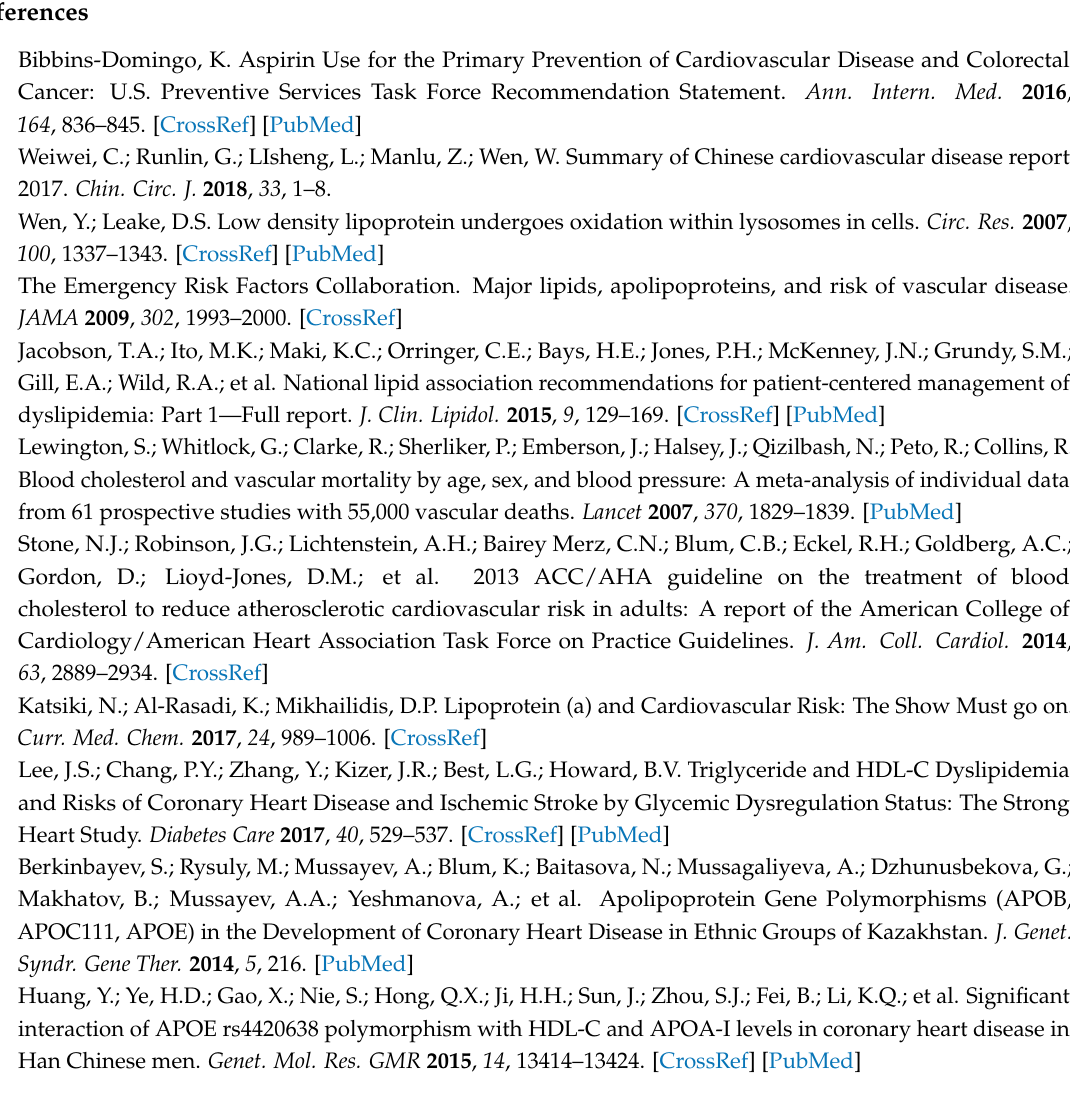
Table S1: Distributions of allele and genotype in the subjects of case and control groups, Table S2: D’value of Linkage disequilibrium for three SNPs of ABCA 1, Table S3: General characteristics, lifestyle factors and genotype distribution between case and control for male and female, Table S4: Associations of genetic models and lifestyles with risk of CAD for male, Table S5: Associations of genetic models and lifestyles with risk of CAD for female. Author Contributions: Author Contributions: We thank all the individuals who participated in the present